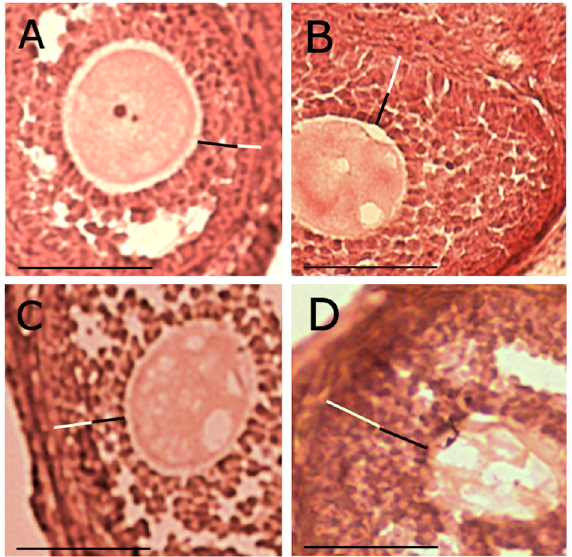
Figure 6. Extension of theca and granulosa cell layers in ovarian follicles. ( A ) negative control mice; ( B ) mice subjected to 21-day treatment with DCIns 250; ( C ) mice subjected to 21-day treatment with letrozole; and ( D ) mice subjected to 21-day treatment with DCIns 500. The thickness of granulosa cell- (black bars) and theca cell-layers (white bars) is marked. Hematoxylin-eosin. Scale bars, 50 μ m. Note the different aspect of oocytes in all panels. Table 1. Thickness of theca (TC) and granulosa cell (GC) layers in control, DCIns- and letrozole- treated mice. Six representative early tertiary follicles from mice subjected to different experimental treatments were measured using the ImageJ software. The TC/GC Ratio (TGR) (mean, SD) is reported below.